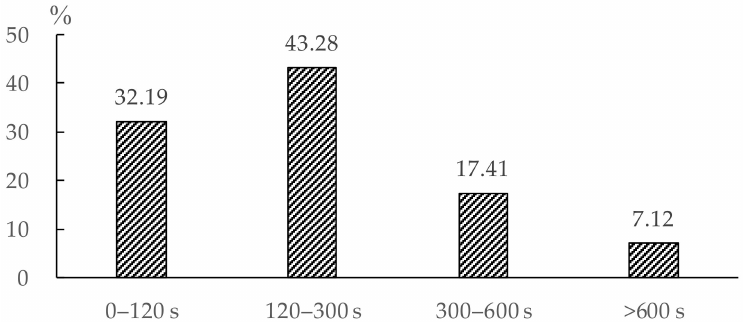
Figure 5. Estimated pre-evacuation time.